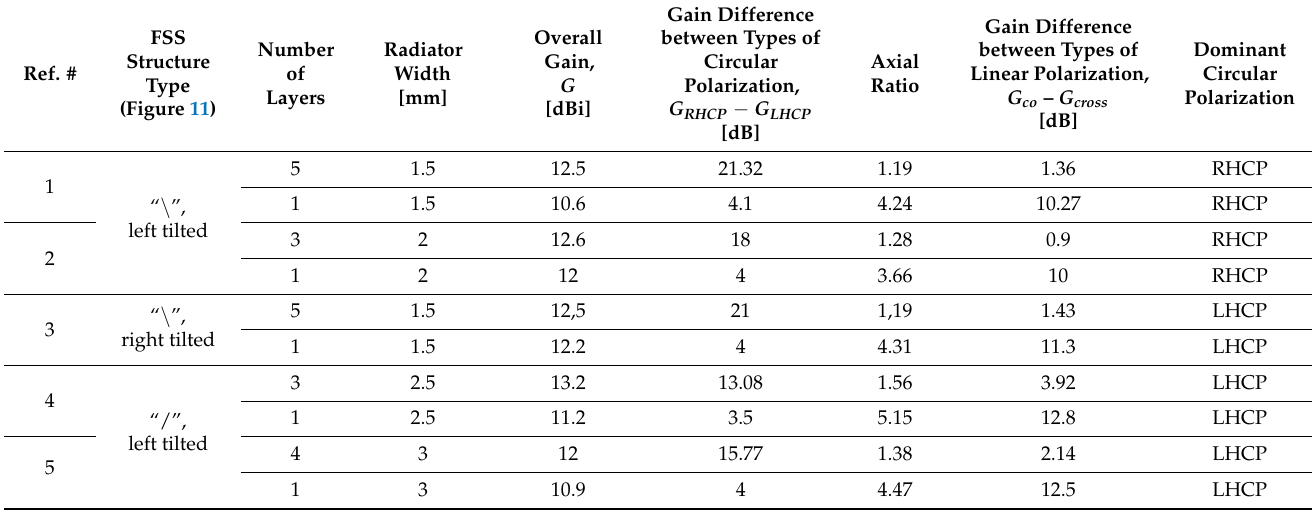
Table 3. Figures of merit of the antenna system for the six types of FSS